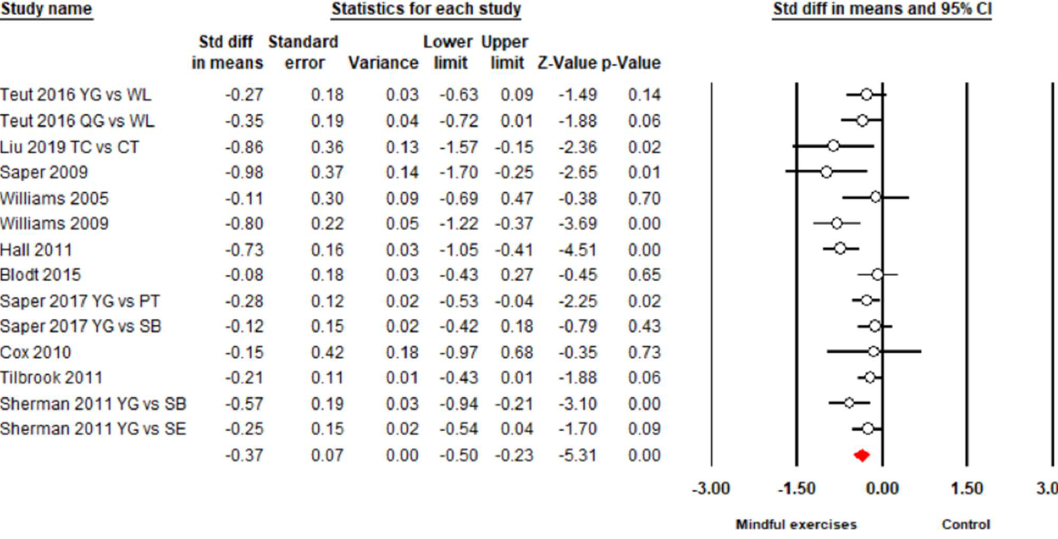
Figure 3. E ff ects of mindful exercises on pain intensity (YG = Yoga, WL = waitlist, TC = Tai Chi, CT = core training, QG = Qigong; PT = physical therapy, SB = self-care book; SE = stretching exercise). The red symbol represents the overall e ff ect size in favor of mindful